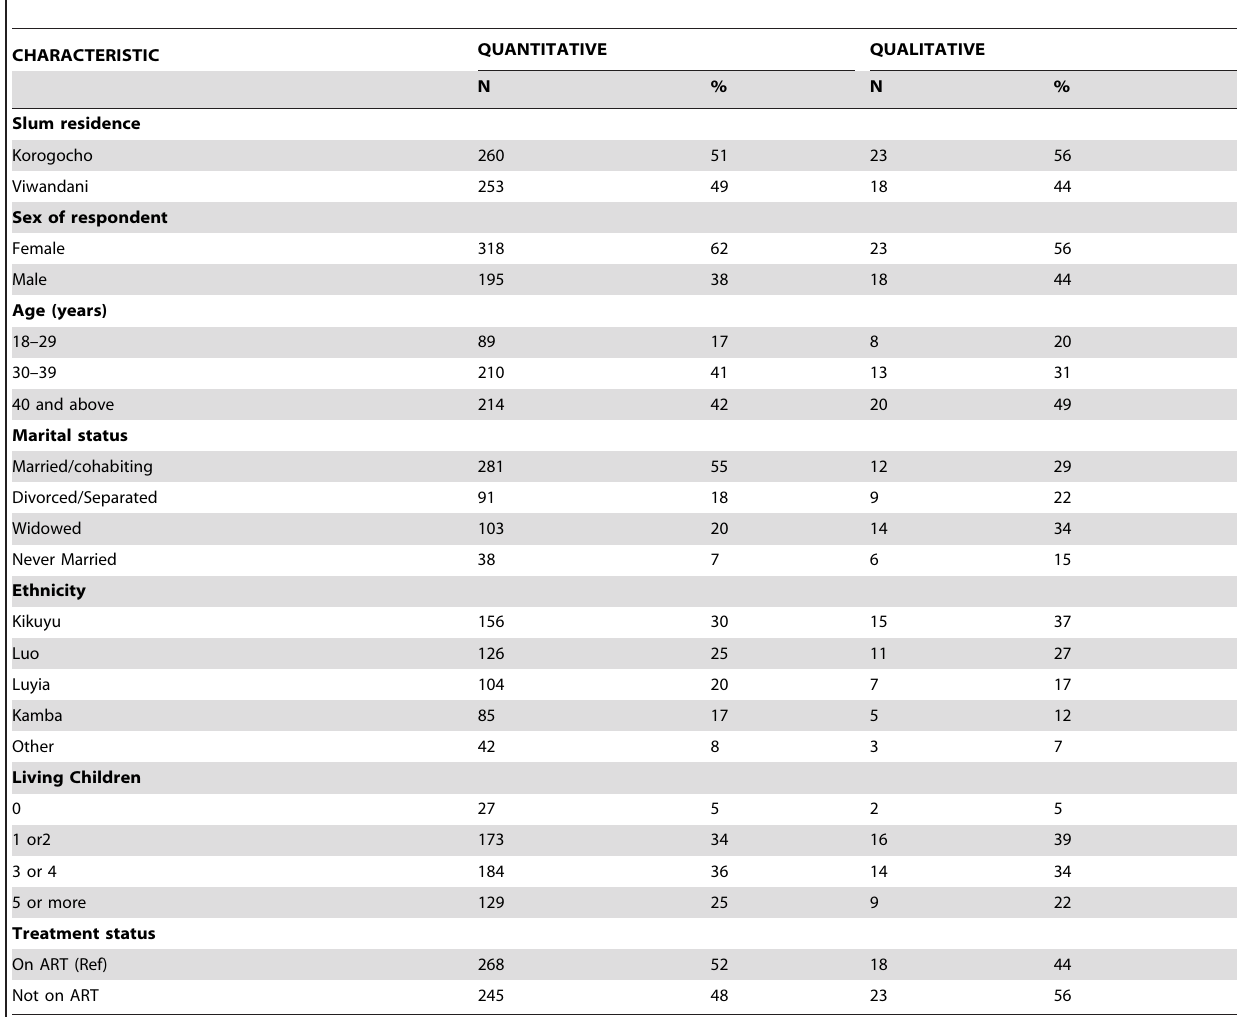
Table 1. Percentage distribution of socio-demographic characteristics of survey (n=513) and in-depth interviewees (n =41) living with HIV/AIDS in Nairobi